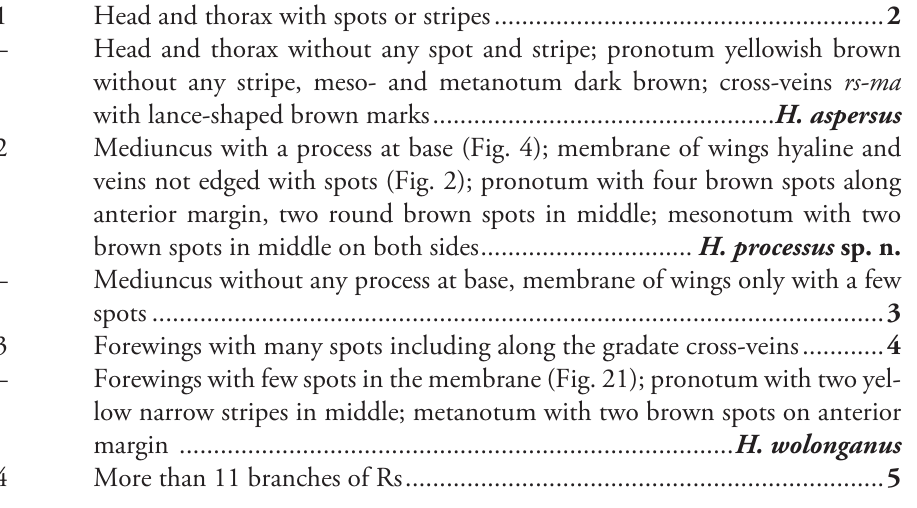
– Forewings with few spots in the membrane (Fig. 21); pronotum with two yel- low narrow stripes in middle; metanotum with two brown spots on anterior